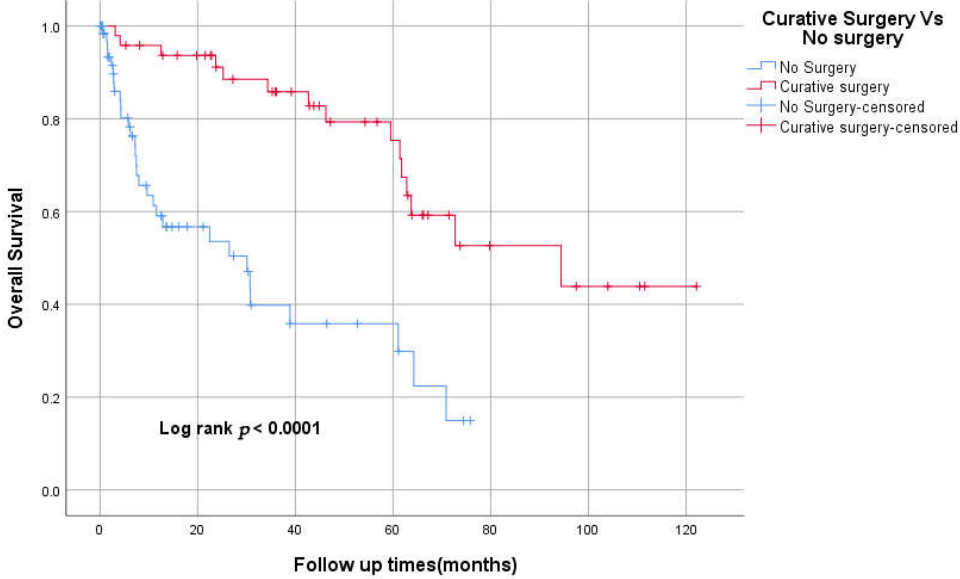
Figure 1. Kaplan–Meier curve of Overall survival for curative surgery vs. no surgery.